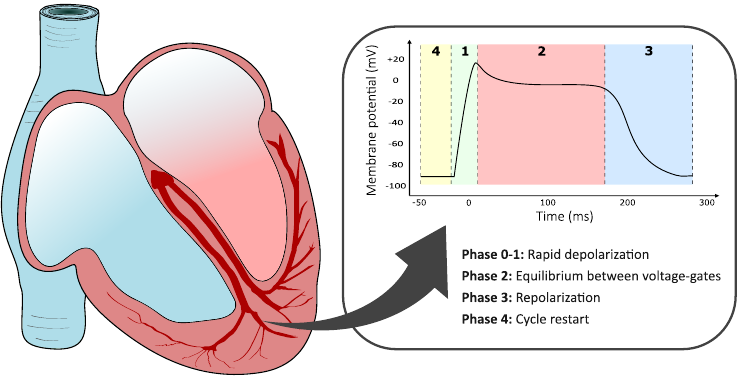
Figure 1. Typical membrane fast action potential of a ventricular myocyte (modified from